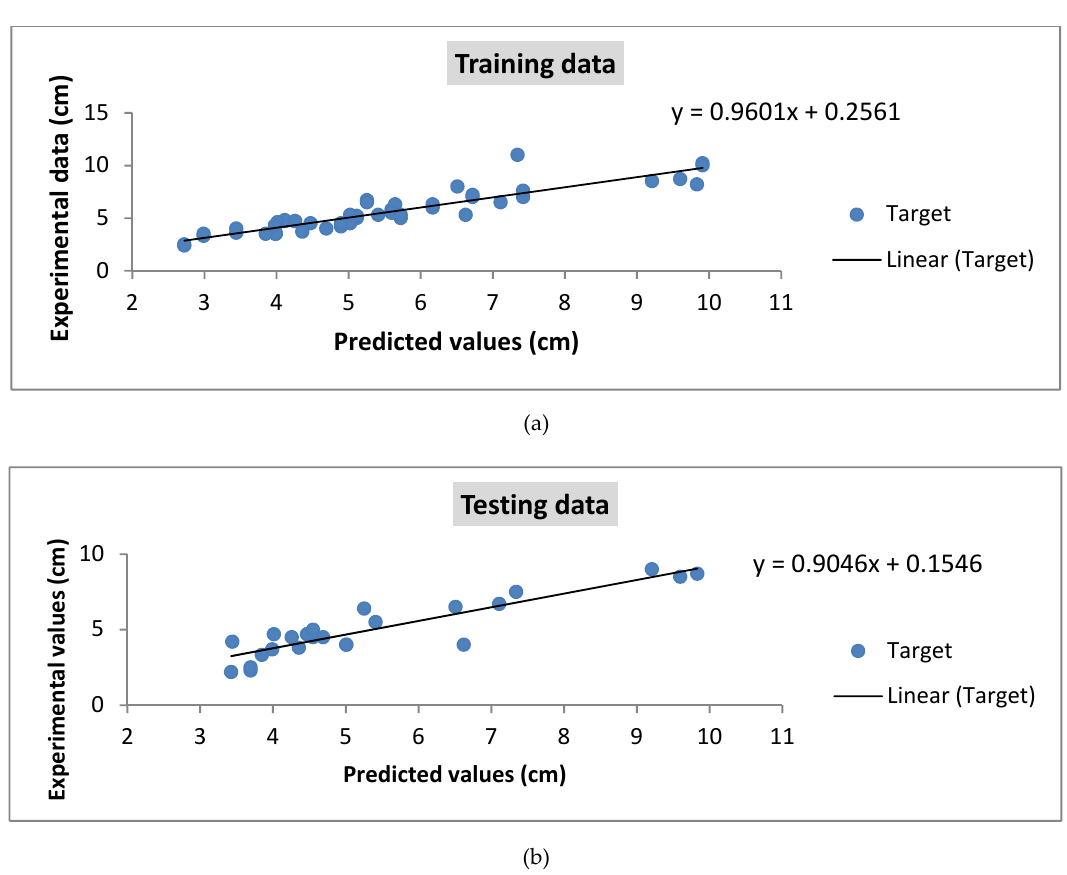
Figure 16. Regression chart for GEP6 prediction model of permeability: ( a ) training data, ( b ) testing data.